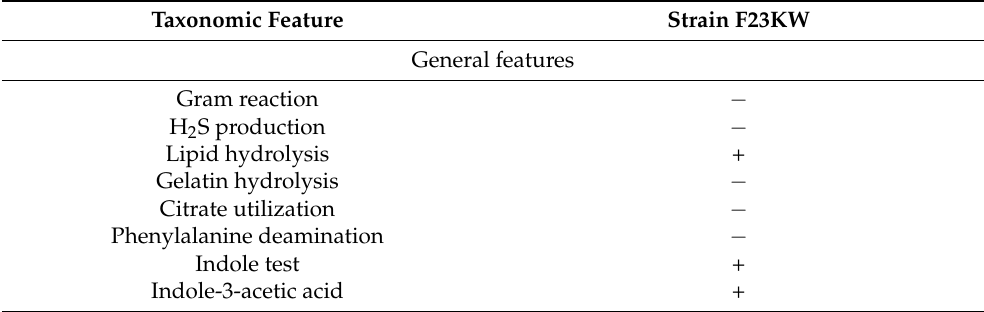
Table 3. Morphological and biochemical features of the selected endophytic bacterial strain